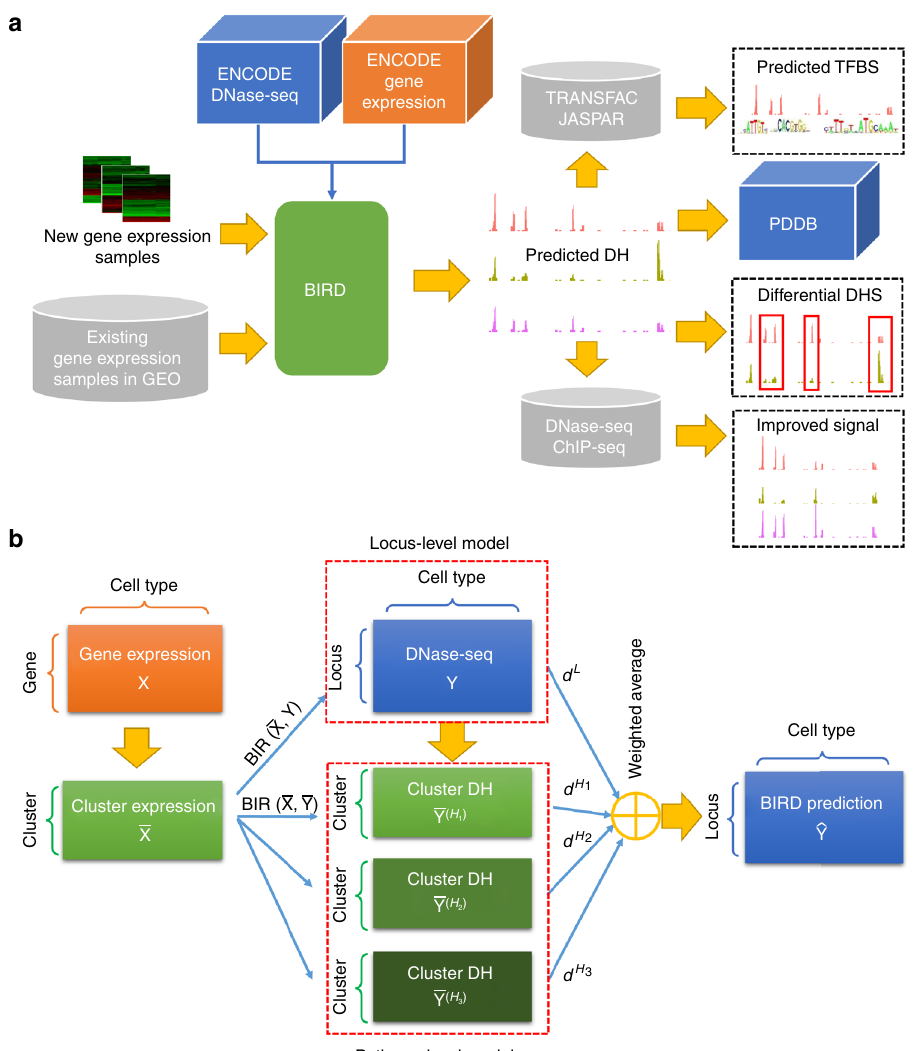
Fig. 1 Concepts of BIRD. a Outline of the study. ENCODE DNase-seq and exon array data are used to train BIRD. Users can apply BIRD to new or existing gene expression samples to predict DH. The predicted DH can be used to predict TFBSs and differential DHSs, convert expression samples in GEO into a regulome database (PDDB), and improve DNase-seq and ChIP-seq data analyses. b Overview of BIRD. Instead of using individual genes as predictors, BIRD groups co-expressed genes into clusters (i.e., gene-cluster) and uses the clusters ’ mean expression levels as predictors. BIRD aggregates two types of (cid:1) (cid:3) (cid:1) (cid:3) models. The locus-level model BIR X ; Y predicts the DH level at each genomic locus. The pathway-level model BIR X ; Y further groups correlated loci (i.e., loci with co-varying DH) into different levels of clusters (i.e., DHS pathways) and predicts the DH level for each pathway. Finally, BIRD predicts DH at each locus by combining the locus-level and pathway-level predictions via model